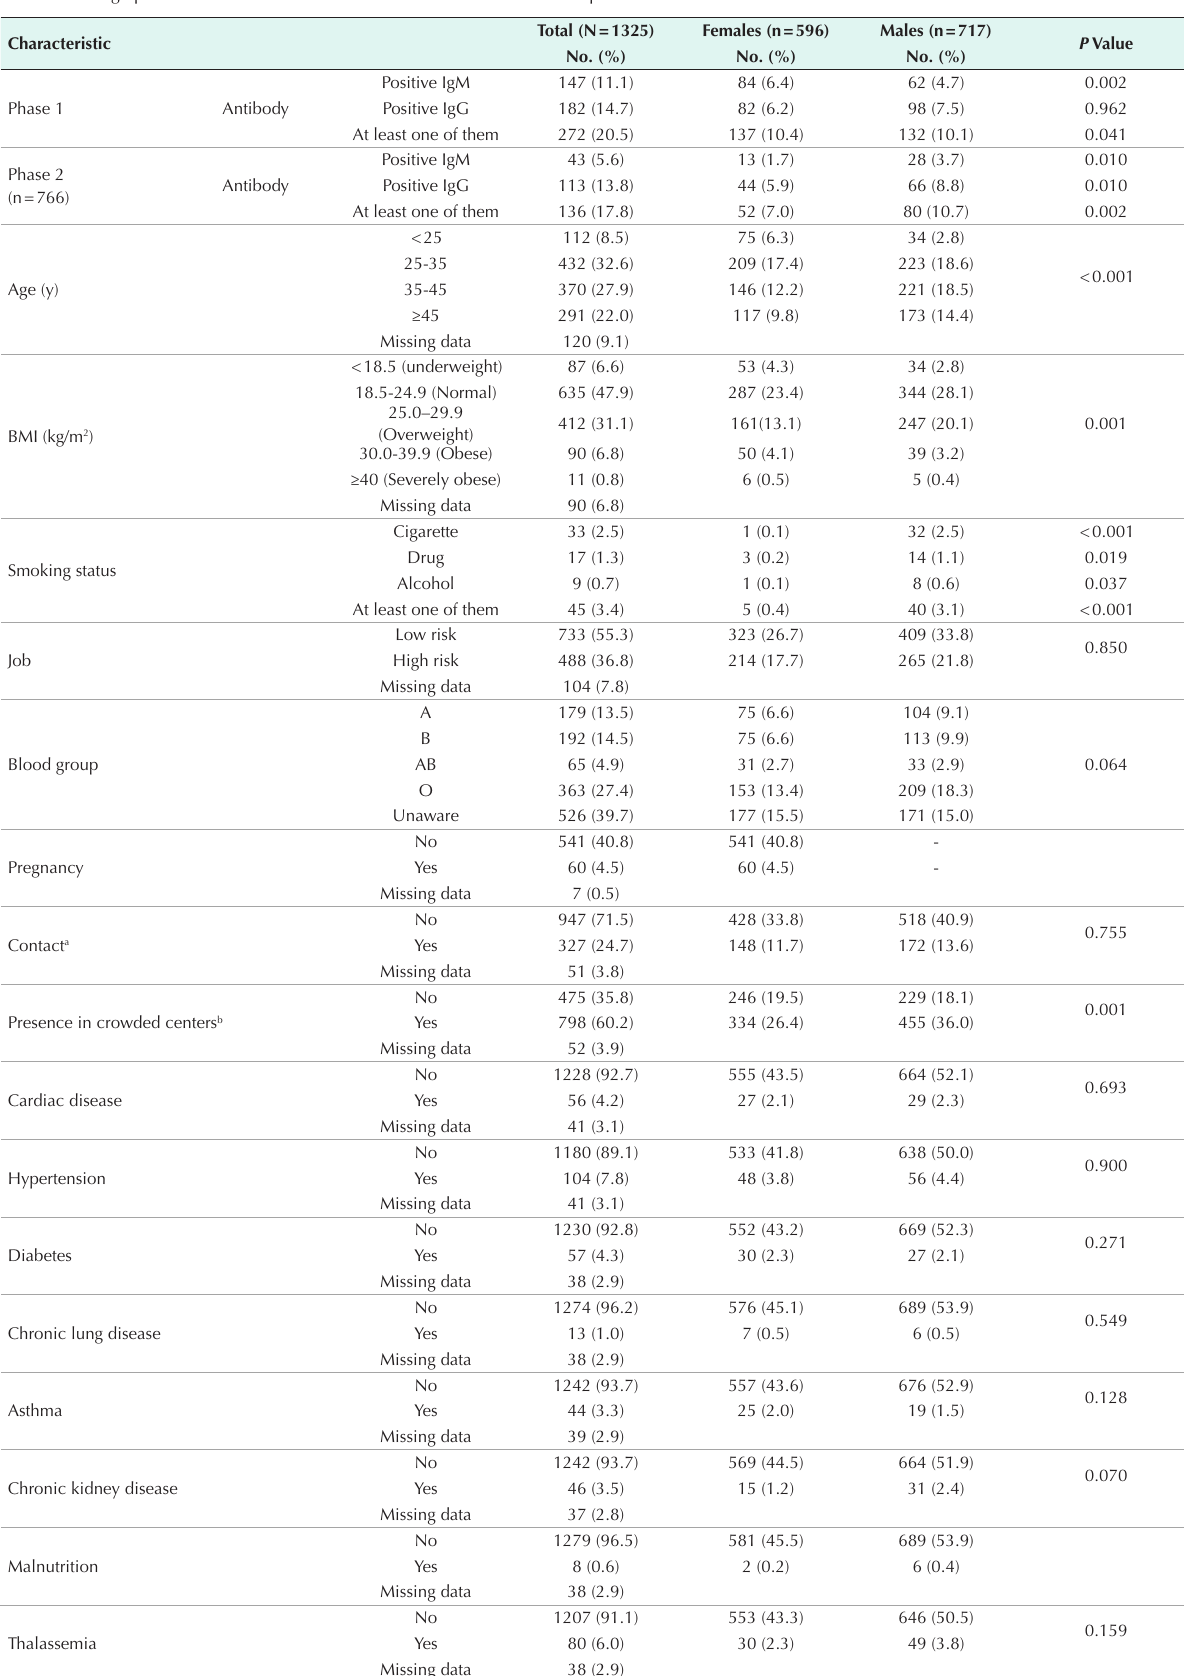
Table 1. Demographics and Clinical Characteristics of Male and Female Participants